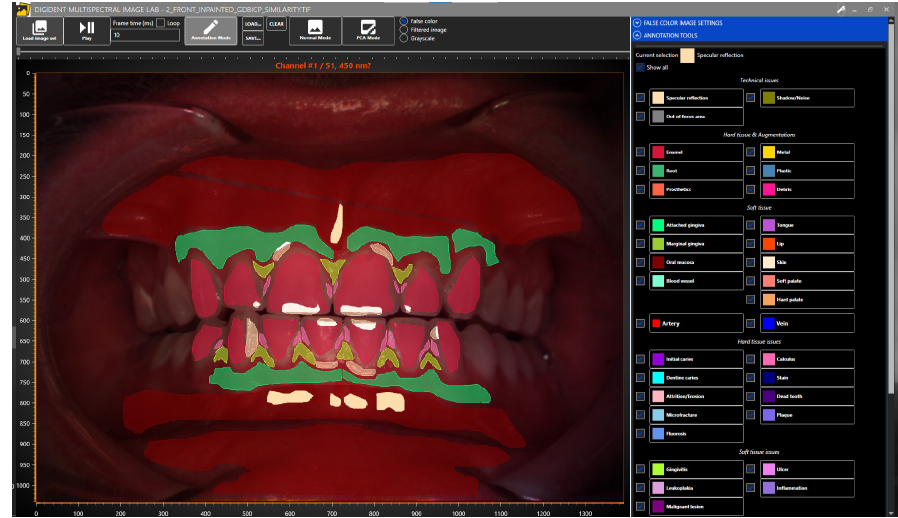
Figure 5. Screen capture of the annotation